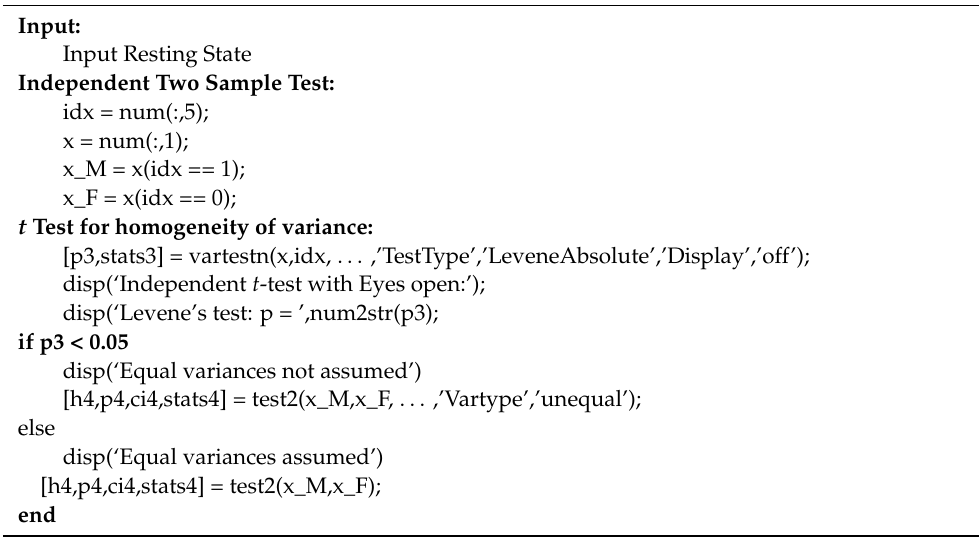
Algorithm 2 t -test of the Image Segmentation optimization